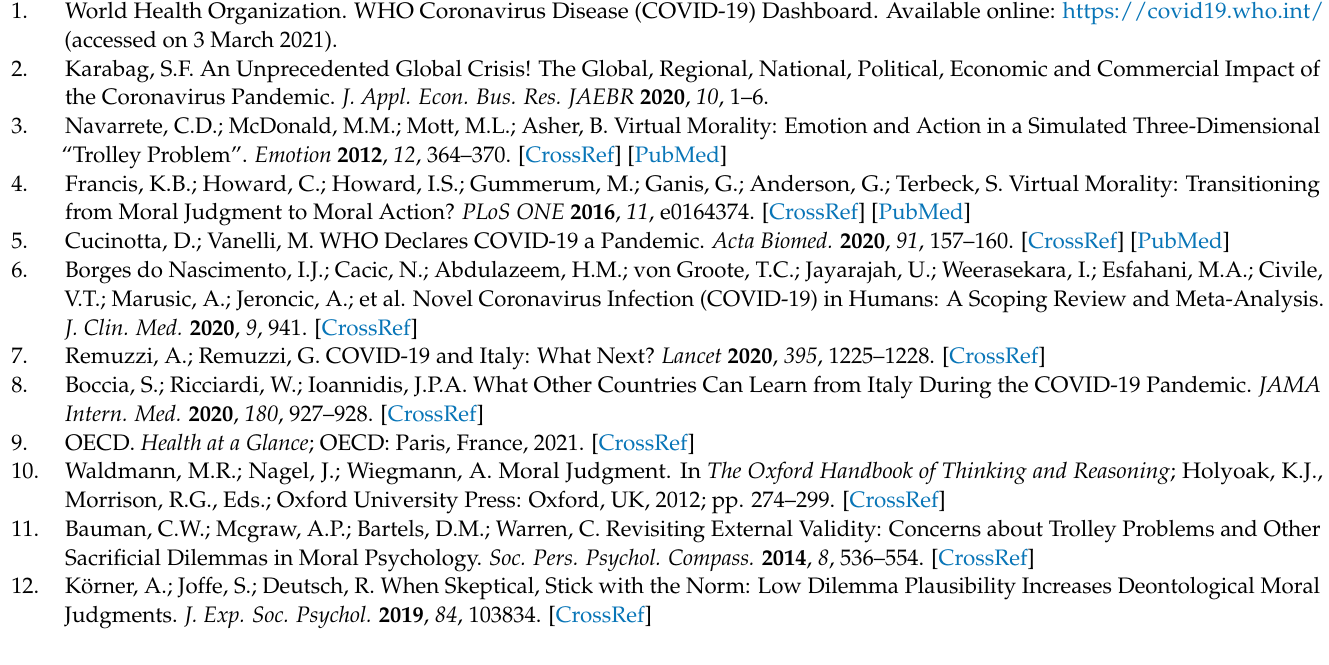
Table S4: Summary of Moral Scenarios Reduced GLMMs; Table S5: Summary of Additional models; Table S6: Summary of Reduced Additional models; Figure S1: Distribution of the responses for each additional scenario; Figure S2: Significant main effects and interactions for the situation assessment regarding the health care system, the economy, and personal situation; Figure S3: Significant main effects and interactions for the additional questions regarding behavior changes, confidence, and long-term consequences. References [99–108] are cited in the Supplementary